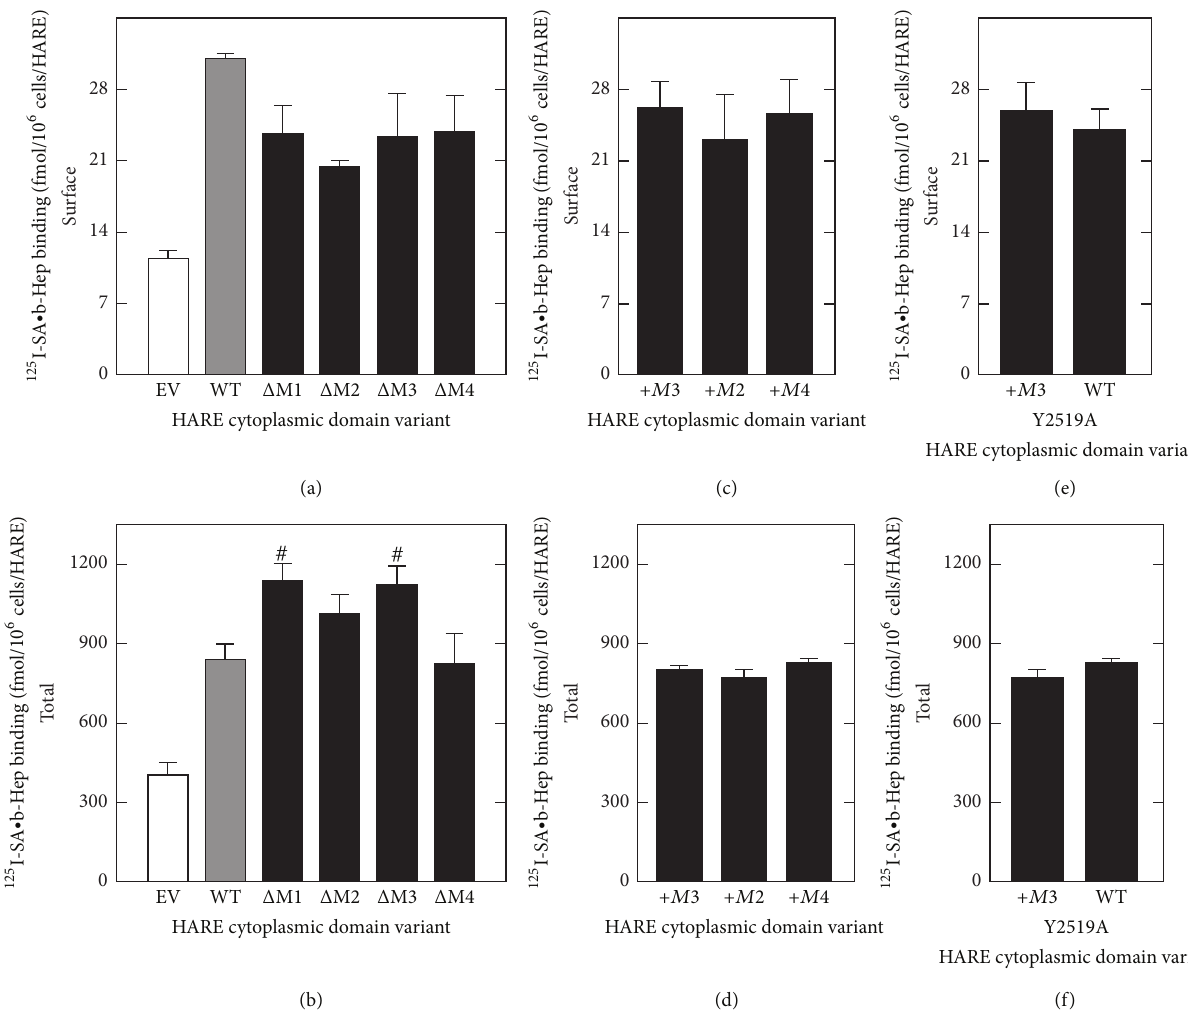
Figure 2: Hep binding to cell surface and total HARE in CD variants. Cells expressing human HARE (WT), the indicated HARE CD mutants, or EV were grown, washed, and preincubated in Endocytosis Medium at 37 ∘ C for 1h to allow clearance of serum-derived glycosaminoglycans bound to HARE. Cells were chilled to 4 ∘ C, washed, and incubated with 125 I-SA ∙ b-Hep complexes at 4 ∘ C and processed as described in Methods section to determine cell surface (a, c, e) or total cellular (b, d, f) specific 125 I-SA ∙ b-Hep binding. Values are means ± SE ( 𝑛 = 6